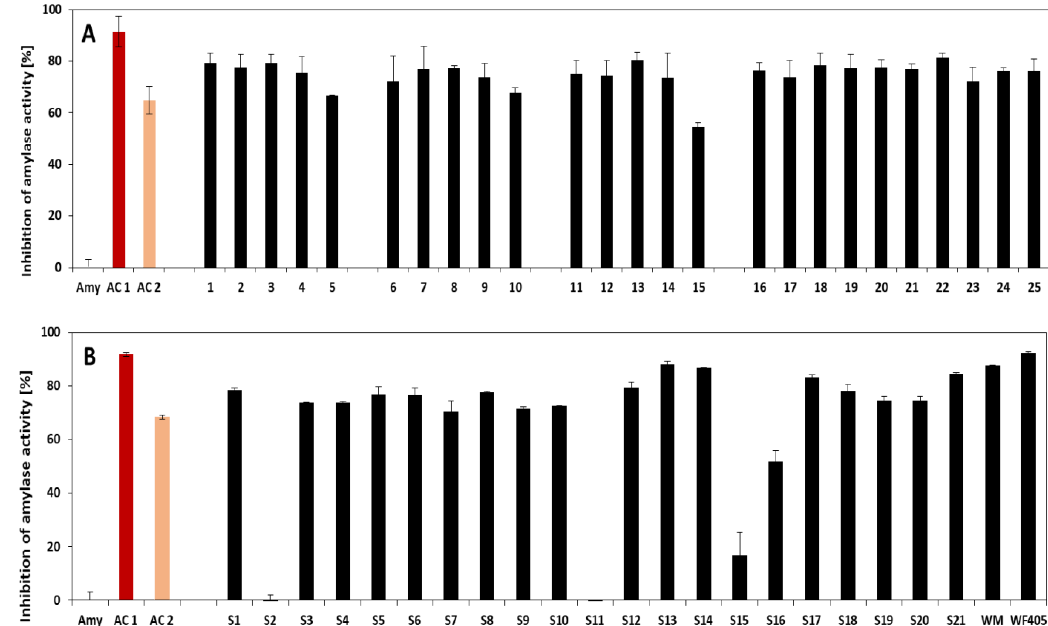
Figure 5. Inhibition of activity by ATIs extracted from German ( A ) and Turkish ( B ) wheat cultivars. Amy = negative control without ATI extract, AC = positive control with acarbose (1 mM and 50 µM). See Tables 1 and 2 for sample allocation. n = 3. 1–5; 6–10, and 11–15 represent the fractions whole-meal flour, centrifuged flour, passage flour, grain bran, and sling bran of the Julius , Ponticus , and Elixier cultivars, respectively. Samples 16 to 25 represent the extracts from A. Bayernkönig , Julius 2017 , RGT reform , Findus , Nordkap , Patras , Ponticus 2017 , Kerubino , Tobias , and Capo , respectively. S1-S21